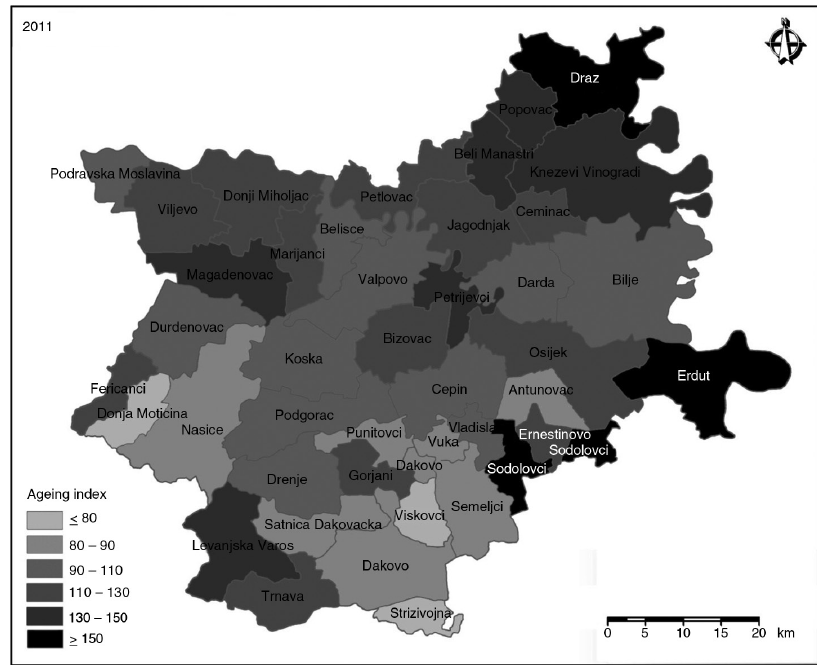
Figure 6. Ageing index of the municipalities in 2011 (post-war state). Source : CBS